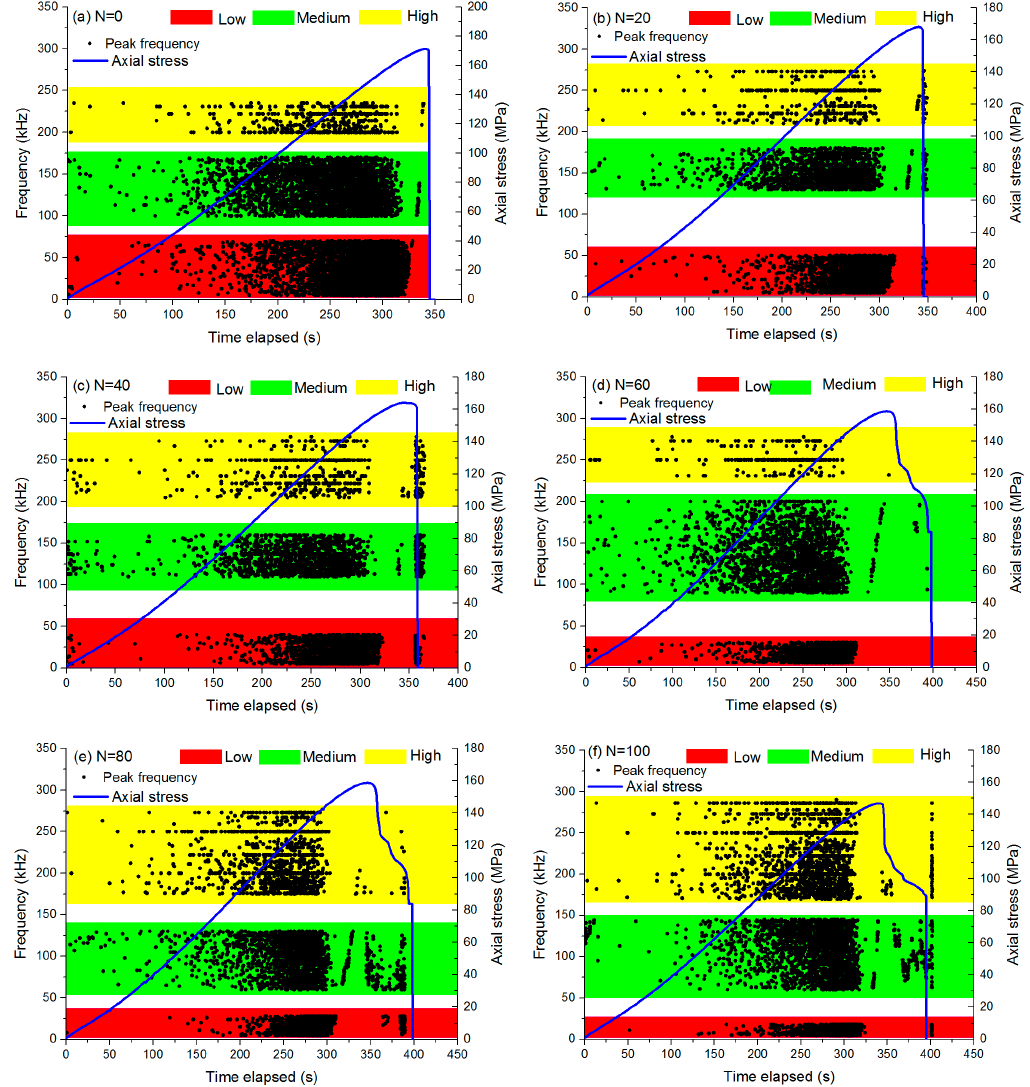
Figure 19. The main frequency characteristics of the samples during compression. ( a – f ) Samples subjected to 0, 20, 40, 60, 80 and 100 F–T cycles, respectively. Table 2. Frequency spectrum characteristics of granite during the fracture process, subjected to different F–T cycles.